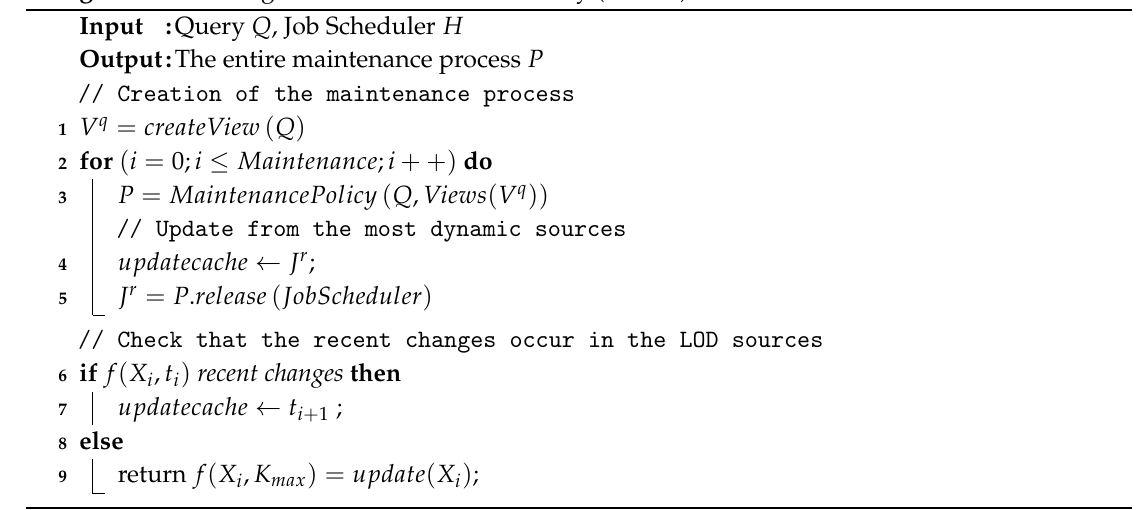
Algorithm 1: Change-Aware Maintenance Policy